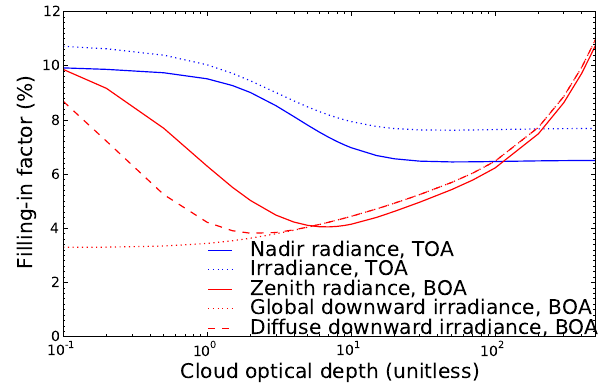
Fig. 4. The filling-in factor at 393.37nm as a function of cloud op- tical depth for a solar zenith angle of 45 ◦ . Cloud bottom is at 1km and cloud top at 2km with the surface at 0.0km and the albedo is 0.03. The ET-spectrum was convolved with a triangular response function with FWHM of 0.26nm. The filling-in factors were calcu- lated from top of the atmosphere (TOA) nadir radiances and diffuse upward irradiances, and bottom of the atmosphere (BOA) global (direct plus diffuse) and diffuse downward irradiances and zenith